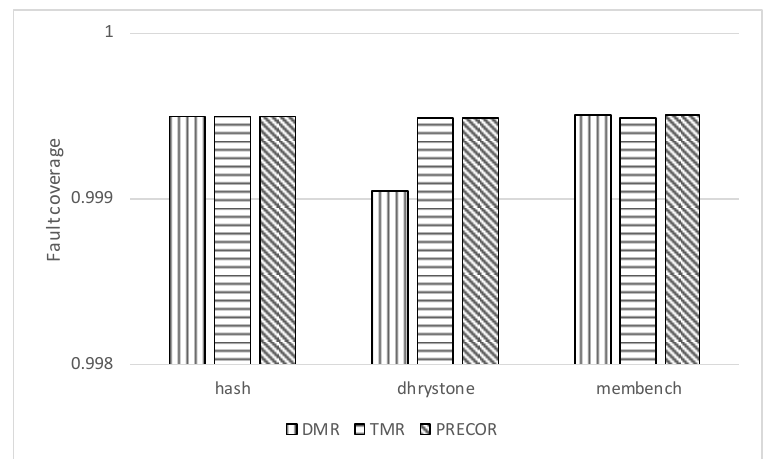
Figure 8. Comparison of fault coverage.